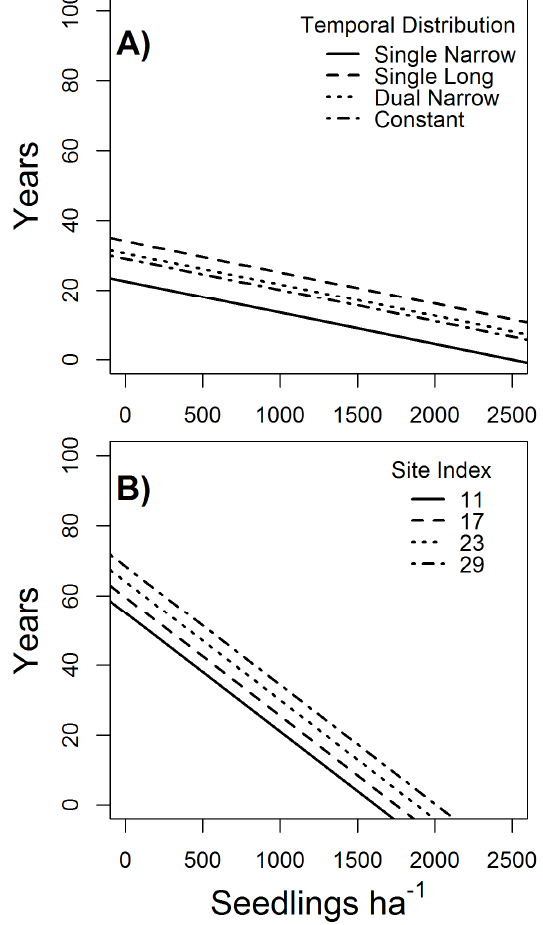
Figure 4. Relationship between significant variables and years to return to within 10% of pre-treatment wind speeds for ( A ) Torching and ( B ) Crowning Indices.